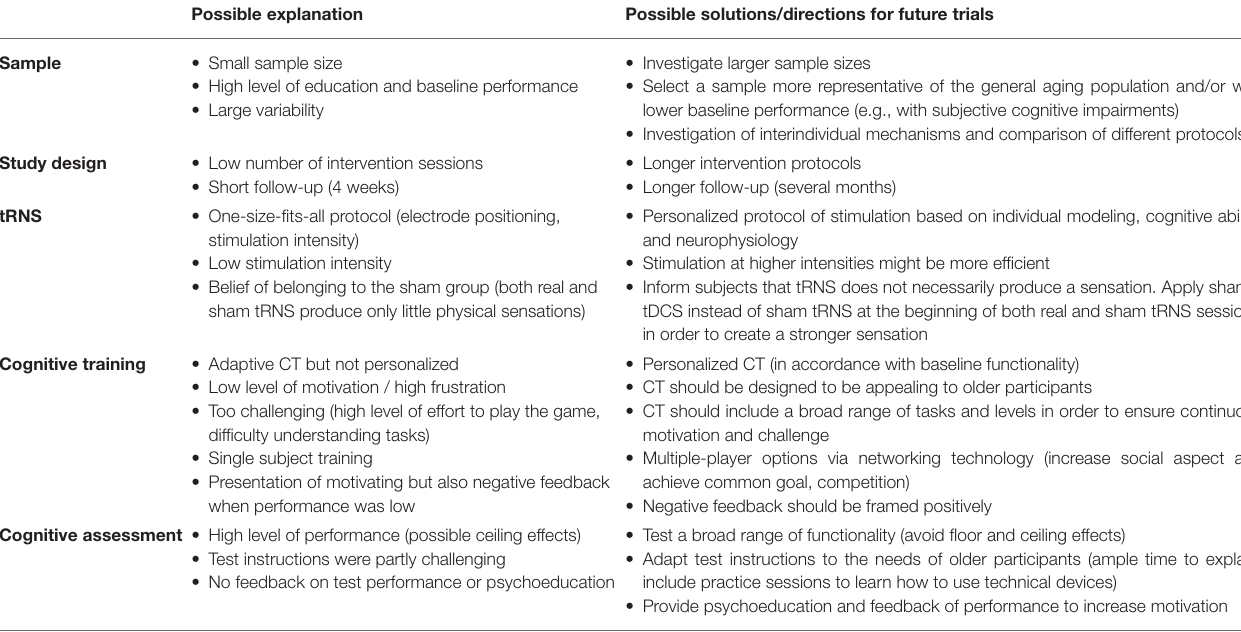
TABLE 4 | Possible explanations and solutions for future